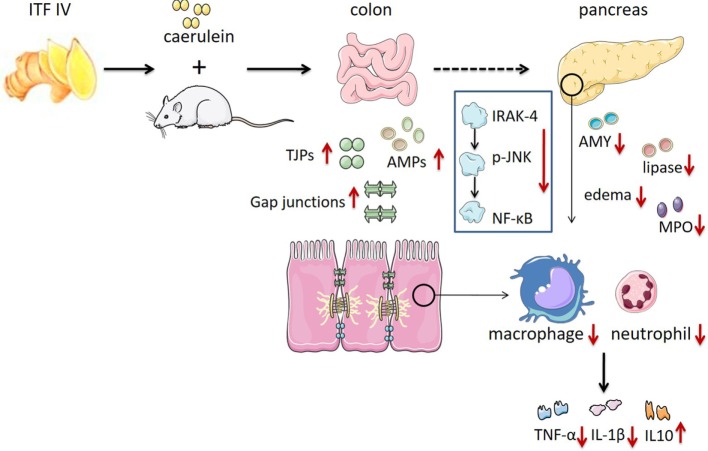
ITF IV protection against AP by reducing pancreatic damage and AP-associated intestinal injury preventing its progression into a systemic inflammatory response. The role of ITF IV on AP in preventing tissues damage and the subsequent inflammatory responses was illustrated. AP, acute pancreatitis; ITF, inulin-type fructans.